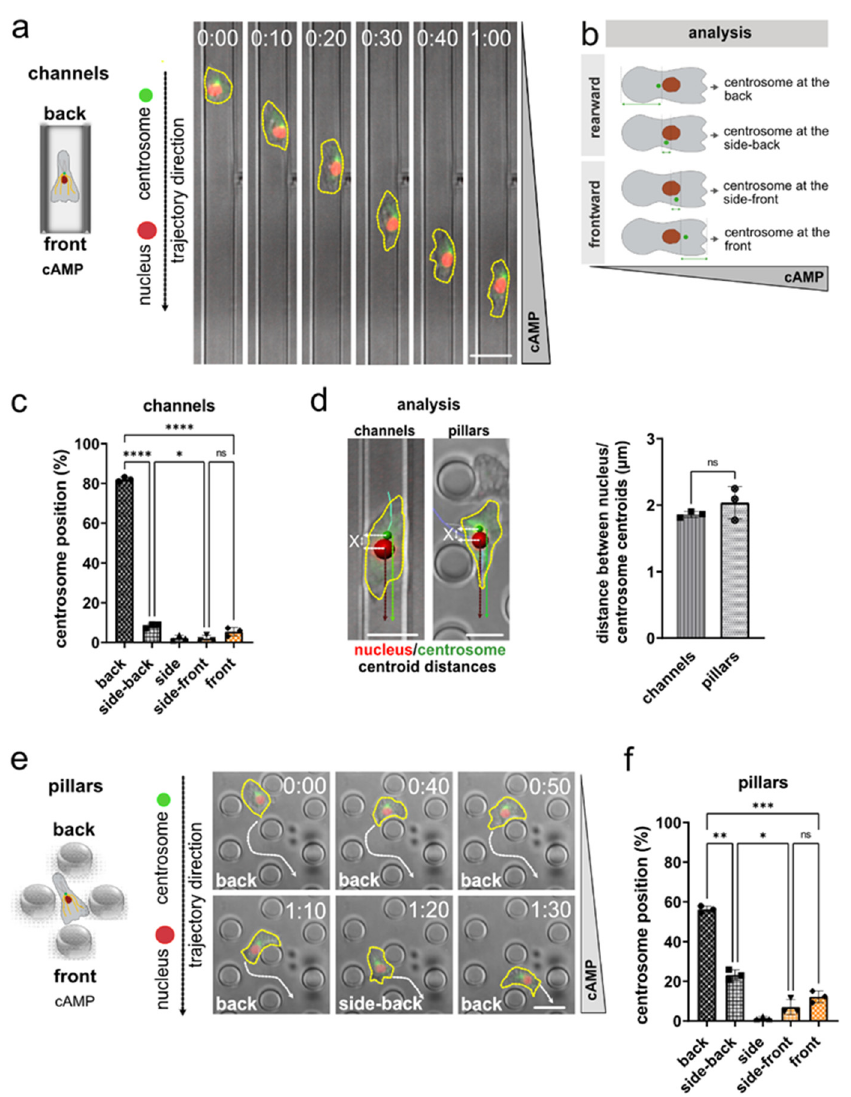
Figure 1. The centrosome of Dictyostelium cells migrating in microchannels or micropillar arrays along a cAMP gradient is preferentially located behind the nucleus. ( a ) Scheme (left) and representative microscopy images (right) of an aggregation competent Dictyostelium cell migrating in a microchannel along a gradient of cAMP. The cells express both the nuclear marker mRFP-histone (red), and GFP-tubulin (green) to highlight centrosomes and microtubules. Time is indicated in min and s at the top. The cell shape is highlighted by a yellow dashed line. ( b ) Principle of quantification. ( c ) Centrosome position during migration in microchannels within a gradient of cAMP. N = 3, number of cells = 32. ( d ) Representative images of Dictyostelium cells showing analysis of nucleus (red) and centrosome (green) centroid distances (indicated by “X”) (left). Histogram (right) displays the quantification of the distances between the nucleus and centrosome centroids during migration in microchannels and micropillar arrays along a cAMP gradient. N = 3, number of cells = 30. ( e ) Scheme (left), and representative microscopy images (right) of a cell migrating in a field of micropillars along a gradient of cAMP gradient, recorded with a time interval of 10 s per frame. The white arrows indicate the trajectory of the cell. The numbers indicate the time in min and s. ( f ) Quantification of the centrosome position during migration in an micropillar array along a gradient of cAMP. N = 3, number of cells = 30. Scale bars are 10 µ m. * p < 0.05, ** p < 0.01, *** p < 0.001, **** p < 0.0001 are significant, and ns = not